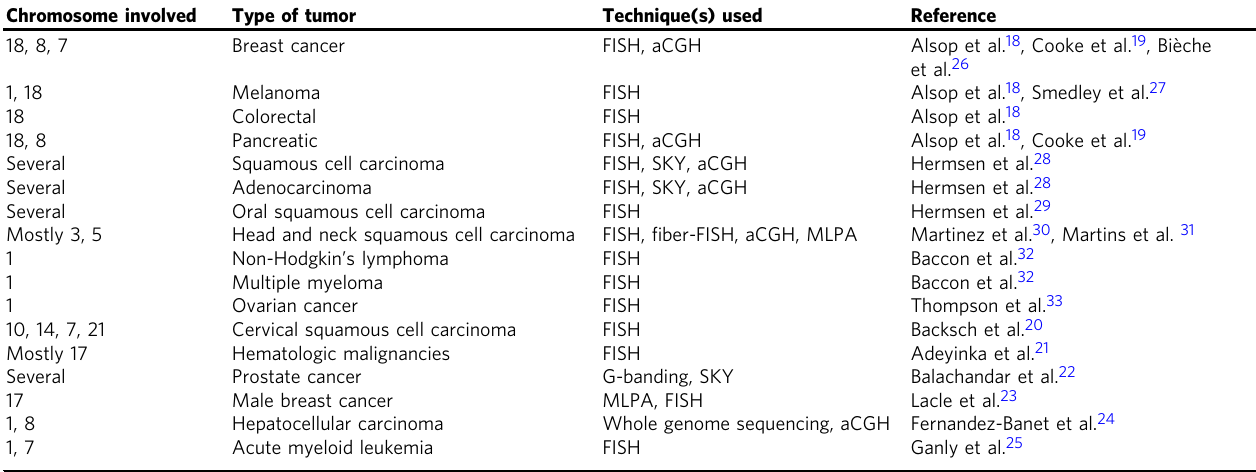
Table 1 List of human tumors with the reported chromosome breaks around the centromere region Chromosome